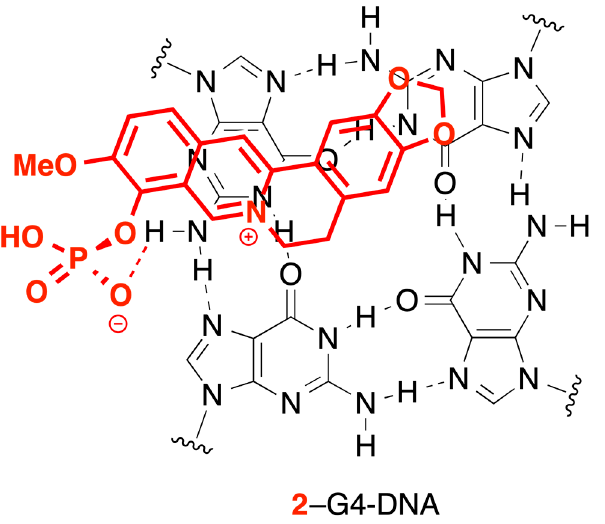
Figure 5. The proposed association of ligand 2 at the terminal quartet of G4-DNA c-myc and c-kit .